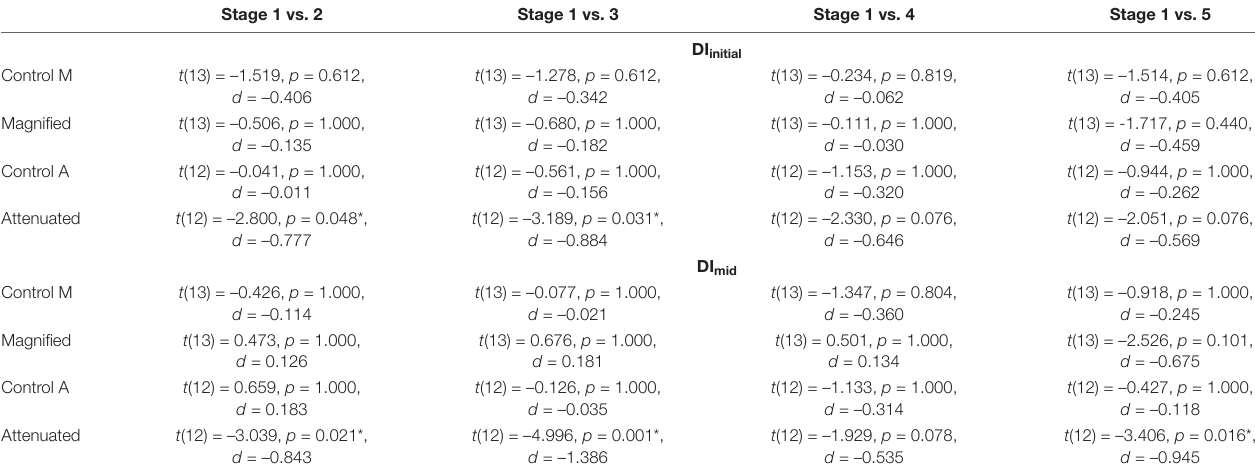
TABLE 1 | Adjusted p -values (paired t -tests, Holm–Bonferroni method) for comparisons of DI initial (top section) and DI mid (bottom section) between Stage 1 (first 5 blocks of 3 trials) and each subsequent stage (also 15 trials) in the Control, Magnified, and Attenuated feedback variability conditions (the two participant groups completing Magnified or Attenuated variability conditions each completed their own Control conditions, labeled Control M and Control A). Stage 1 vs. 2 Stage 1 vs.